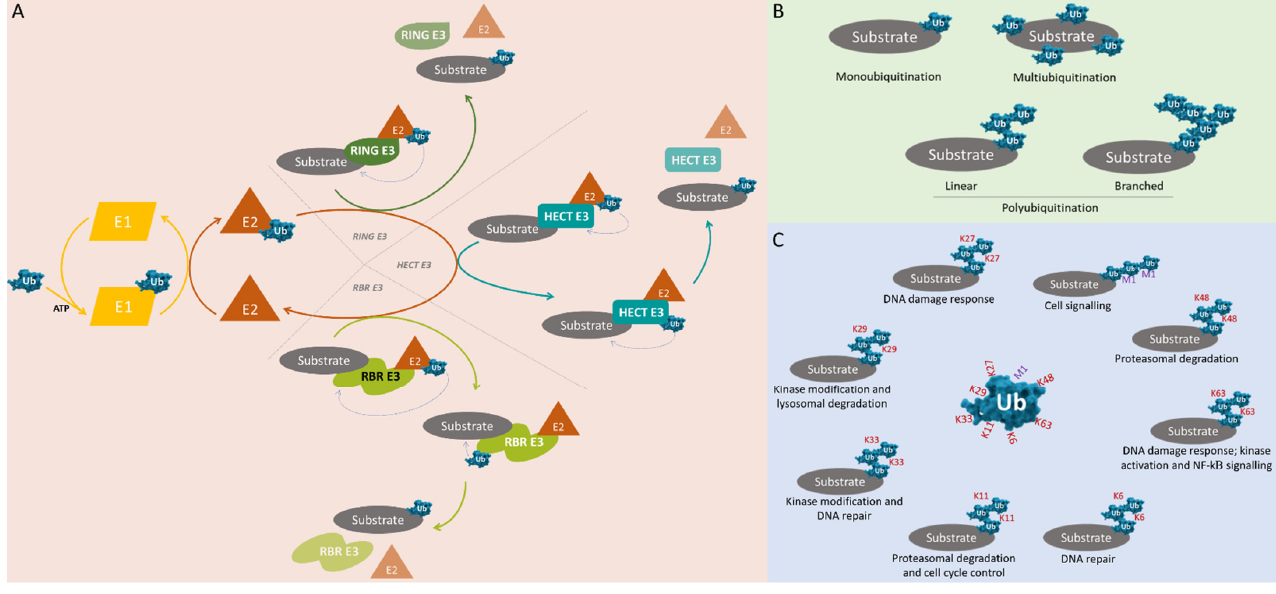
Figure 1. Overview of the ubiquitination process and its functional implications. ( A ) Process that allows the binding of ubiquitin (Ub) to the substrate: activation of ubiquitin by E1 (an ATP-dependent reaction), transfer of ubiquitin to E2 conjugation enzymes and finally the interaction between E2 and E3 ubiquitin ligases (RING-, HECT- or RBR-E3- mediated reactions) allows the connection between ubiquitin and the substrate. RING-type E3s catalyze substrate protein ubiquitination through a direct transfer, while HECT-type and RBR-type E3s serve as an intermediate receptor of ubiquitin from the E2 conjugation enzymes before its transfer to the substrate proteins. ( B ) Different types of ubiquitination: binding of a ubiquitin monomer at a single site (monoubiquitination) or several monomers at different sites (multiubiquitination) of the substrate, and ubiquitin–ubiquitin linkage in substrate, leading to the formation of linear or branched chains (polyubiquitination). ( C ) Different modes of polyubiquitination through the M1 methionine residue or through the seven different lysine residues K6, K11, K27, K29, K33, K48 and K63 of ubiquitin lead to different substrate